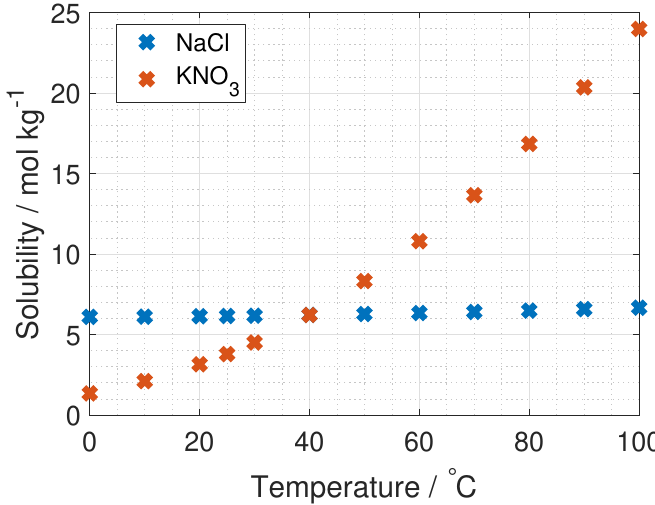
Figure 4. Solubility dependency on temperature for NaCl and KNO 3